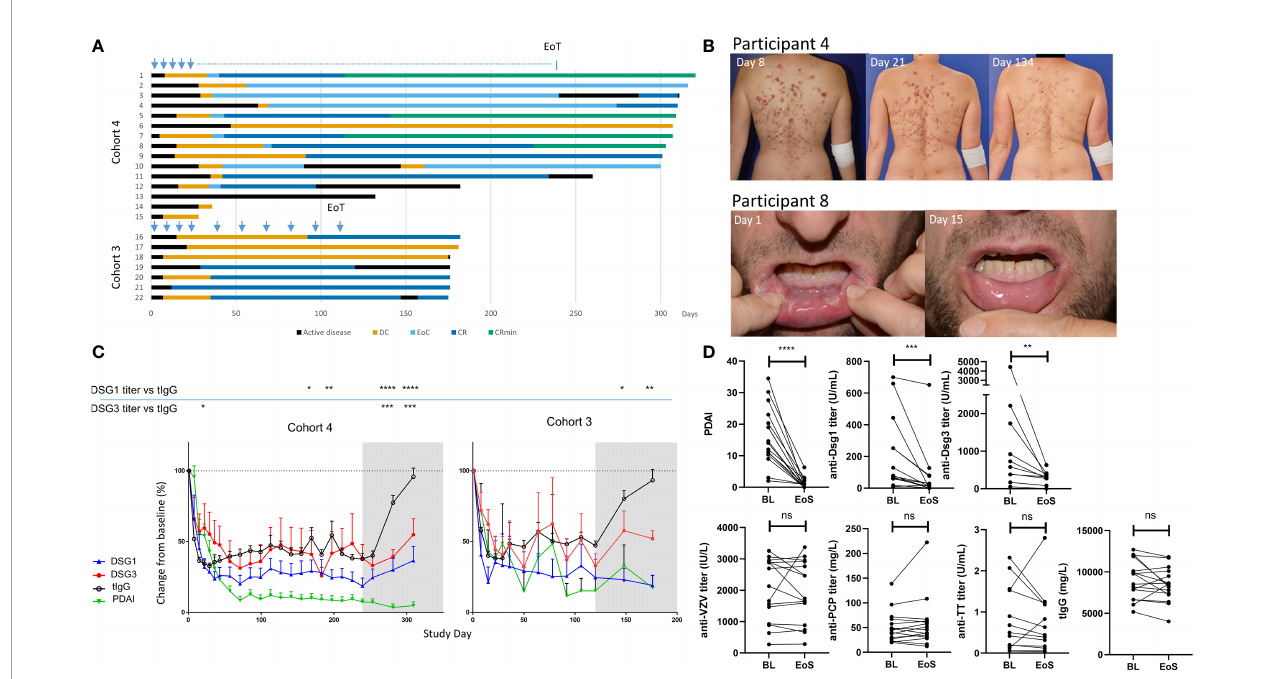
FIGURE 1 | Sustained clinical responses and transient general reduction of total serum IgG levels following efgartigimod treatment. (A) Clinical responses to efgartigimod are depicted for all participants in cohorts 3 ( n = 7) and 4 ( n = 15). Participant numbers correspond to those used in Table 1 . Blue arrows indicate when efgartigimod was administered, and the blue dotted line indicates every other week administration time period in participants who achieved EoC. (B) Clinical responses of singular representative trial participants with pemphigus foliaceus and pemphigus vulgaris, respectively, are shown. (C) Longitudinal changes in pathogenic (anti-Dsg-3 or anti-Dsg-1) as well as total IgG (tIgG) and PDAI activity scores are represented. The gray shaded area indicates efgartigimod treatment- free follow-up period. Means are compared using two-way ANOVA multiple comparison with Dunnett ’ s post-test. (D) Pathogenic (anti-Dsg-3 or anti-Dsg-1), total IgG (tIgG), and non-pathogenic antibodies titers (anti-VZV, anti-varicella zoster virus; TT, tetanus toxoid; PCP, pneumococcal capsular polysaccharide) are compared between BL and EoS for all participants. Wilcoxon matched-pairs test was performed. * p ≤ 0.05; ** p ≤ 0.01; *** p ≤ 0.001; **** p ≤ 0.0001. BL, baseline; EoS, end of study; DC, disease control; EoC, end of consolidation; CR, complete clinical remission; CRmin, complete clinical remission with minimal treatment; Pt, participant; ns, non signi fi